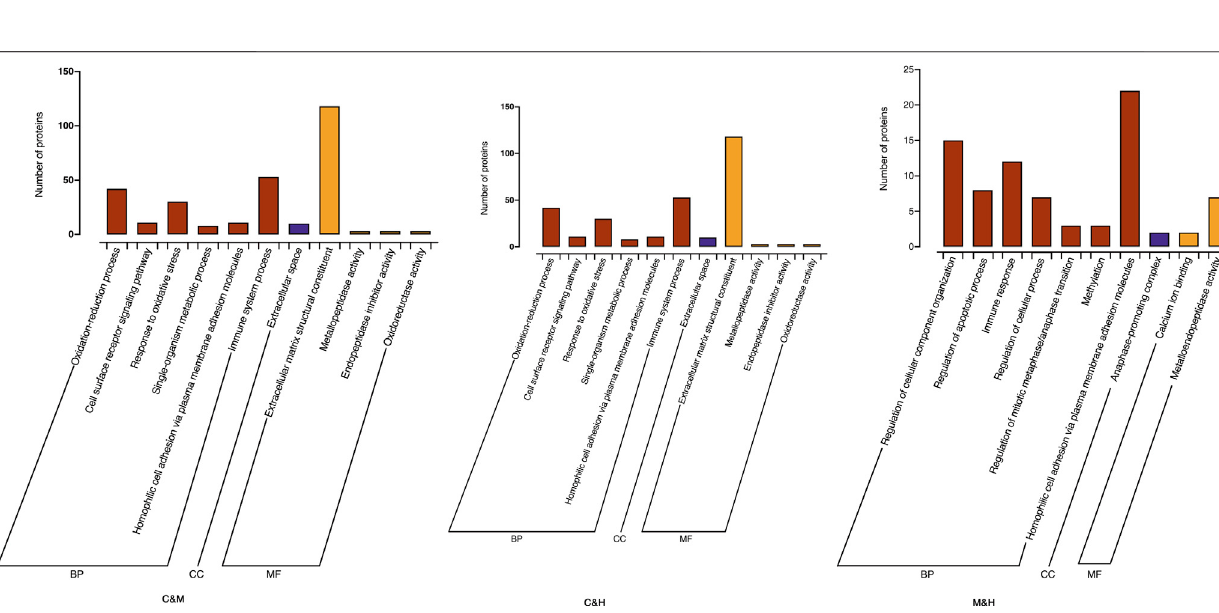
Frontiers in Pharmacology |